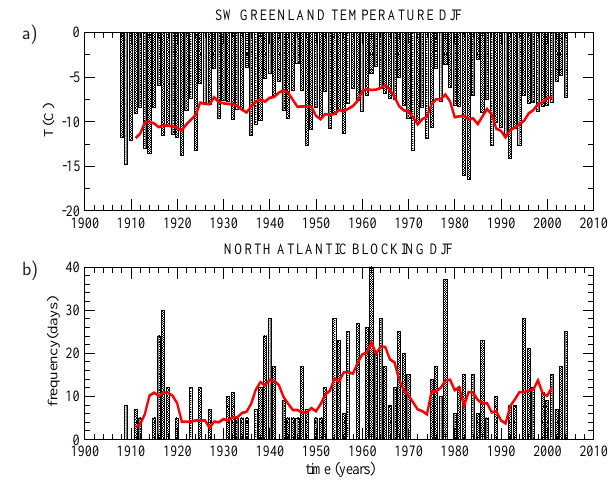
Fig. 2. (a) Southwestern Greenland winter temperature index (Vinther et al., 2006) (bar) and its decadal variation (7-year run- ning mean) (red) for the period 1908 to 2005. (b) Blocking index (bar) and its decadal variations (7-year running mean) (red) for the same